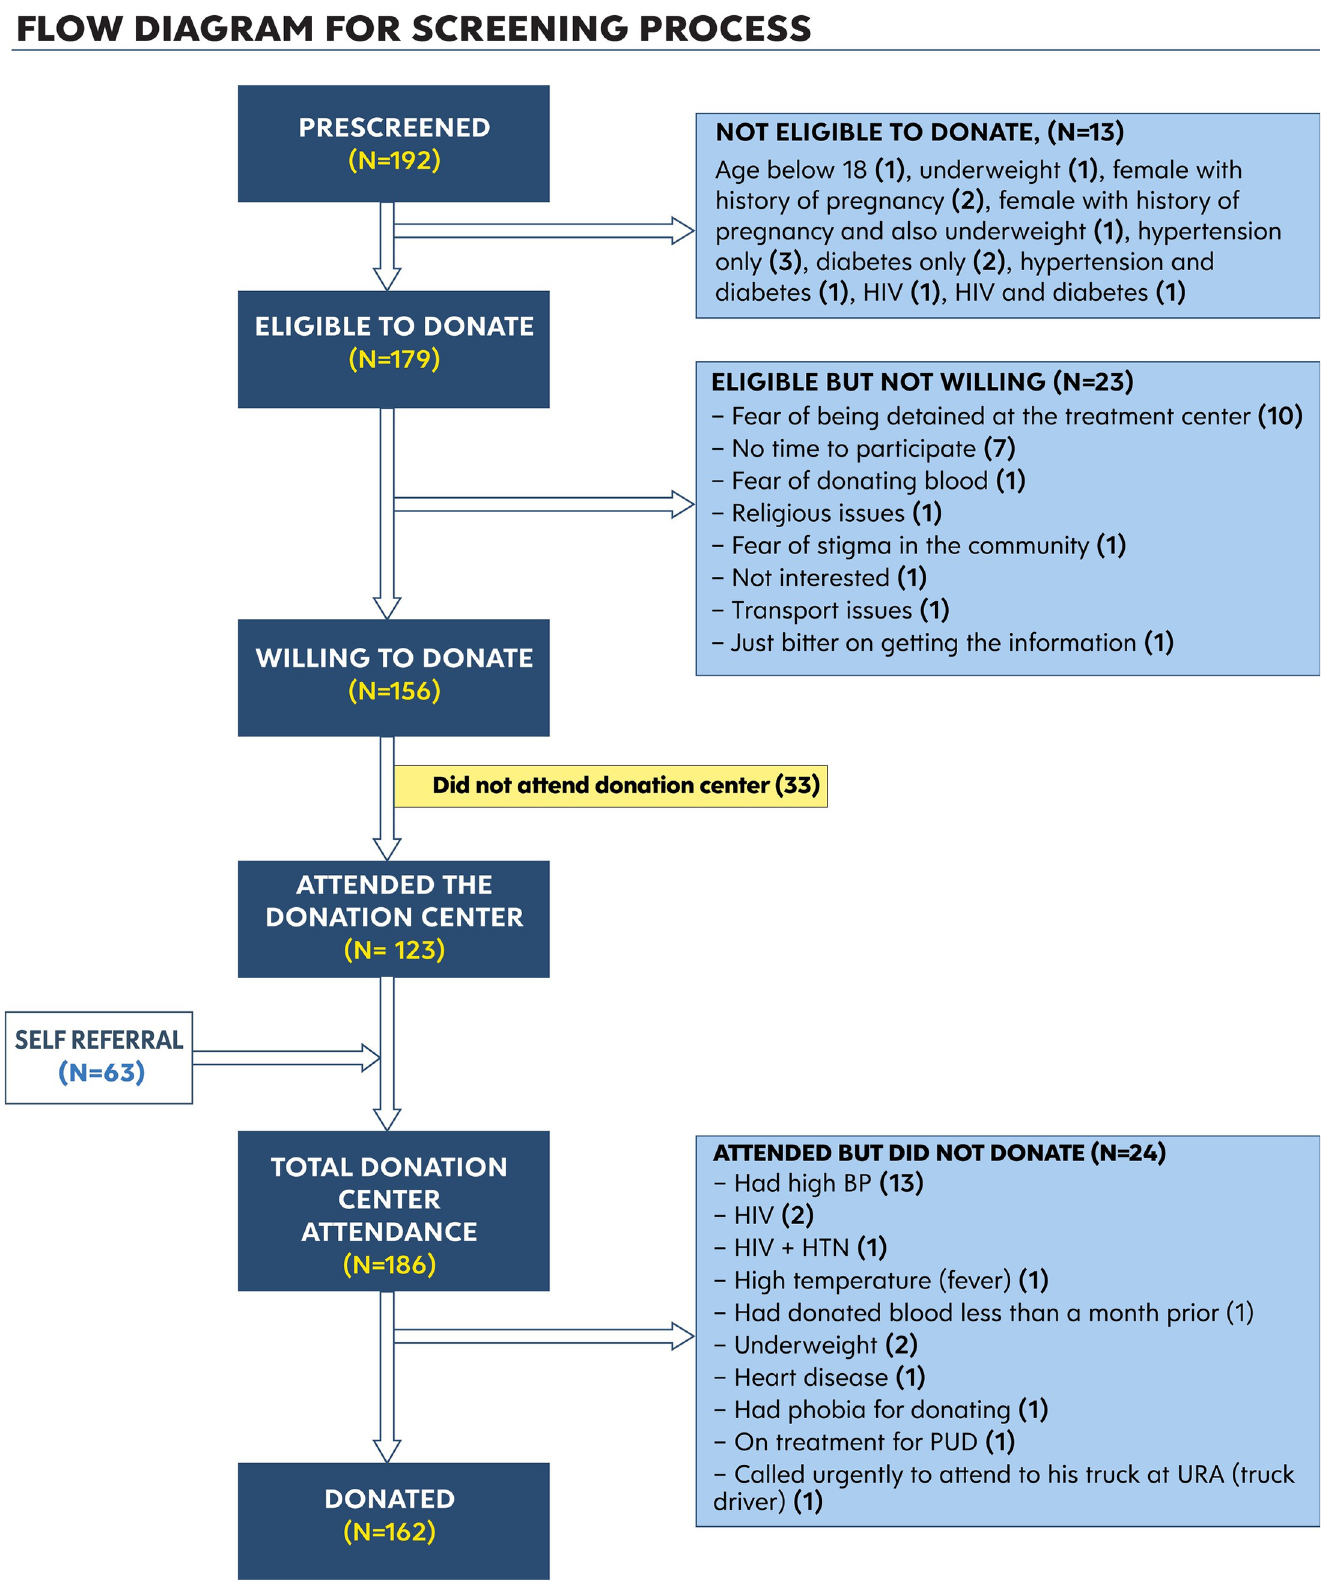
Fig 1. Flow diagram for screening process. https://doi.org/10.1371/journal.pone.0252306.g001 PLOS ONE | https://doi.org/10.1371/journal.pone.0252306 June 17,